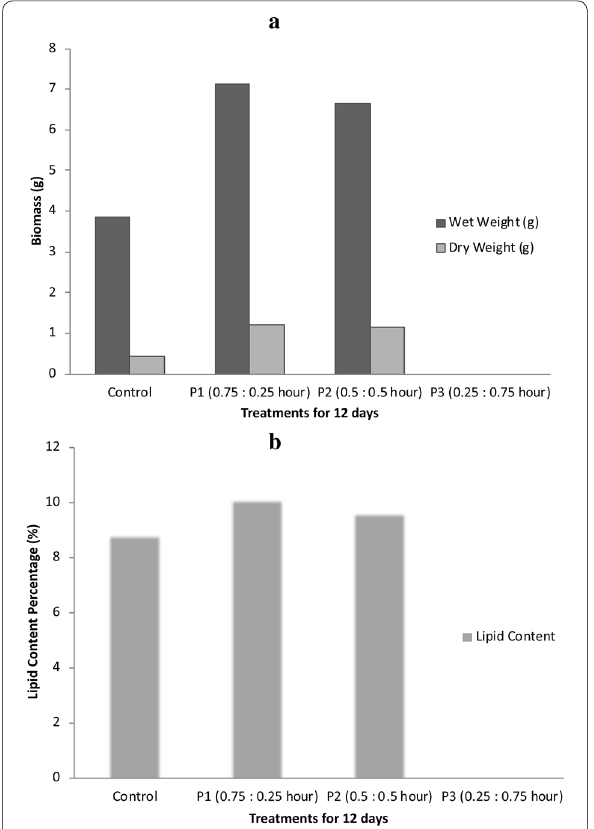
Fig. 8 Histogram of (a) biomass of Nannochloropsis sp., and (b) lipid content percentage